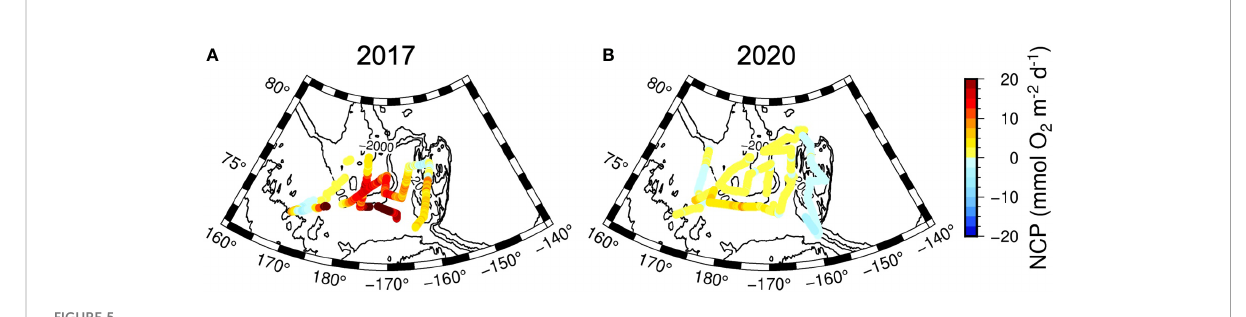
FIGURE 5 Horizontal distribution of NCP in (A) 2017 and (B) 2020.